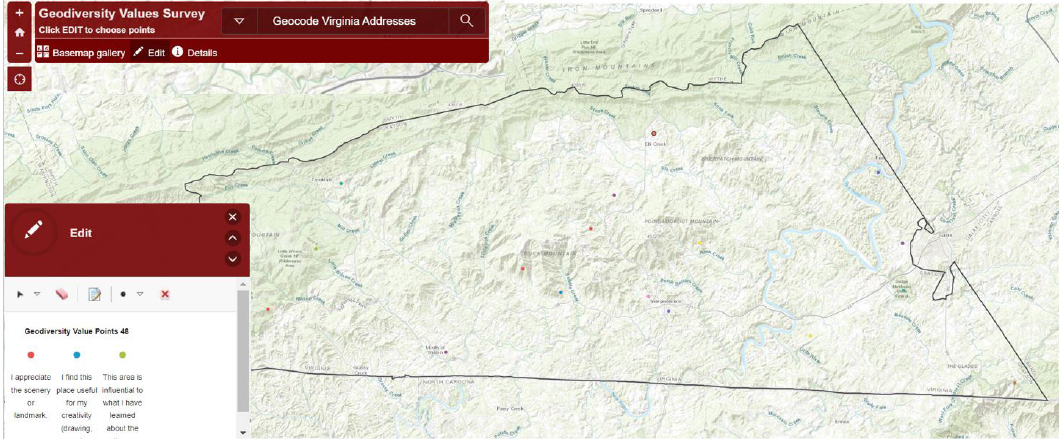
Figure 3. Example of the online PPGIS interface provided to survey respondents. Respondents interacted with the online map interface by selecting among the ten individual service point markers on the screen’s right panel (Figure 3) and dragging and dropping the markers to a location on a basemap of their choice (e.g., Imagery, Streets, Navigation, Open Street Map, USA Topo Maps) to facilitate geolocation.